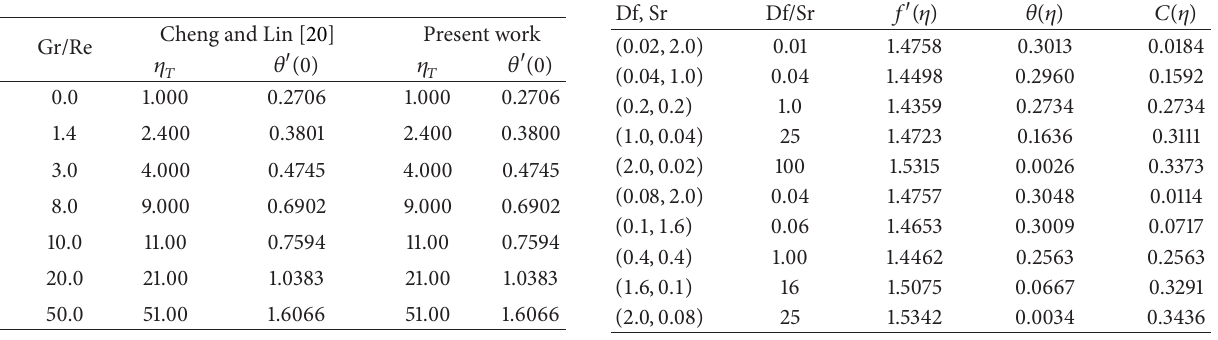
Table 3: Comparison of the values of velocity, temperature, and concentration for different values of Df and Sr with 𝜂 = 0.5 and 𝑁 = 0.5 for aiding external flow (Gr/Re = 0.1).